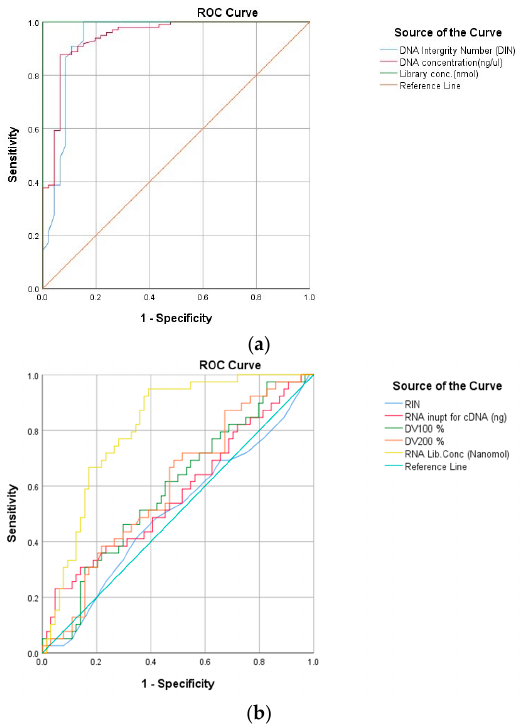
Figure 6. ROC analysis of FFPE samples. ( a ) DNA, ( b ) RNA. Table 4. Area under curve (AUC) of ROC analysis for DNA and RNA parameters.